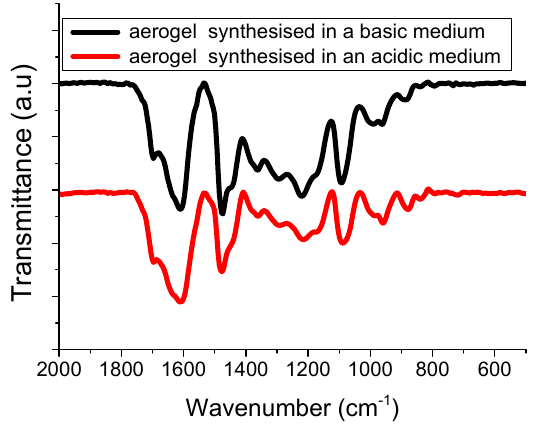
Figure 5. Infrared spectroscopy (IR) spectra of dry aerogels.